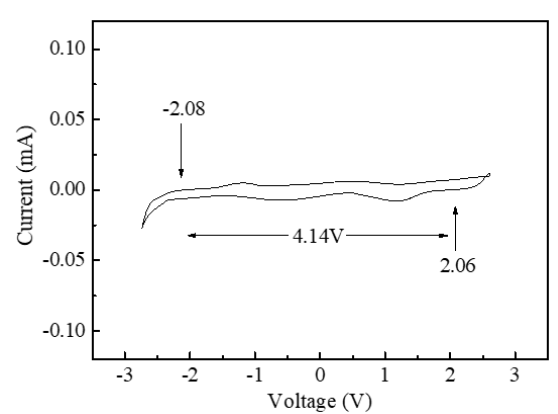
Figure 5. CV curve of the ILPE-Zn-4 membranes at a scan rate of 10 mV s − 1 .